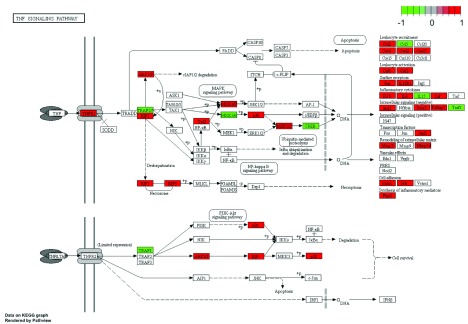
Detailed view of differentially expressed gene in the KEGG TNF-signalling pathway.